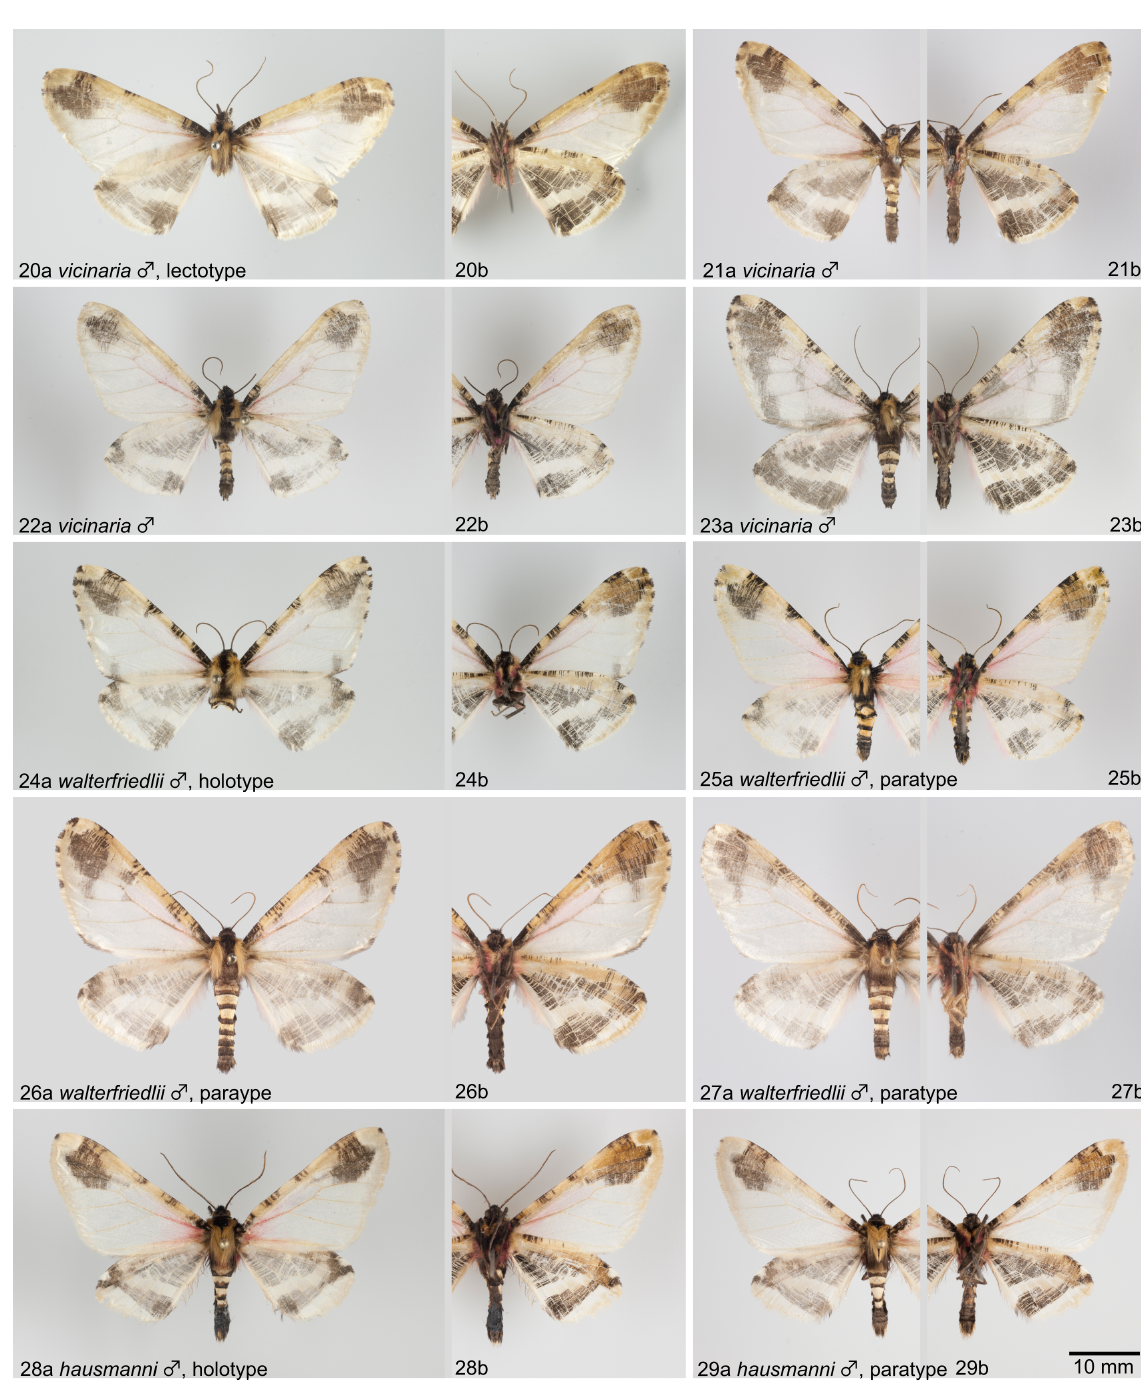
Figs 20–29. Adult moths, ♂♂ (a = dorsal view; b = ventral view). 20 . Callipia vicinaria Dognin,